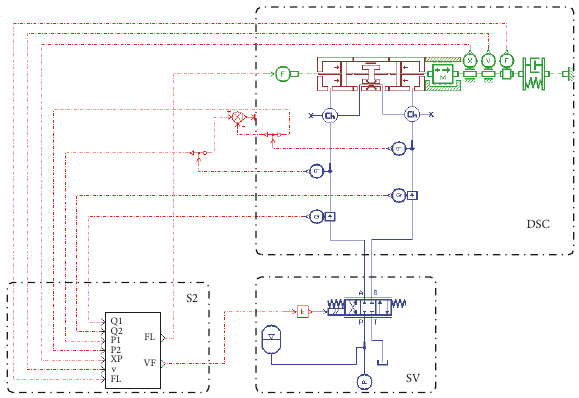
Figure 2: Dynamic pressure cylinder electrohydraulic servo pres- sure system AMESim and Simulink cosimulation